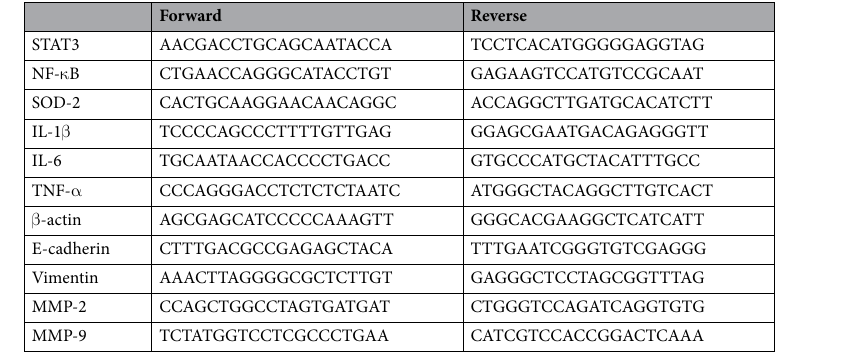
Table 2. Human primer sets used for